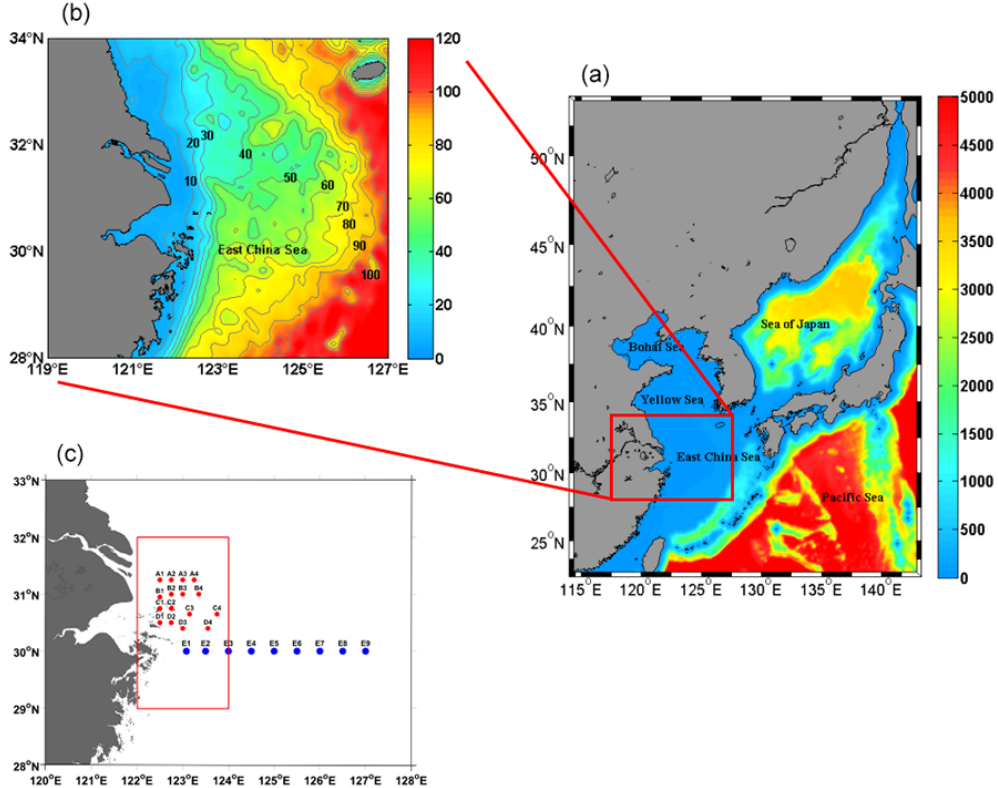
Figure 1. (a) Model domain and depth. Red box is the region of Fig. 1b. (b) The model bathymetry (shading map, unit: meter) of East China Sea. (c) Red dots are the station observation in August 2011; blue dots are the section observation in August 2011; the red rectangle indicates the region used for the calculation of N 2